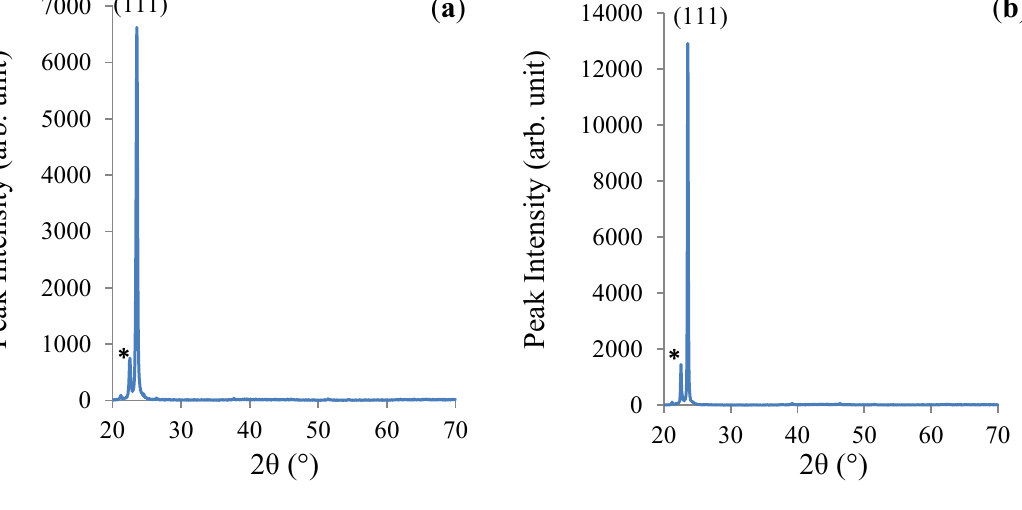
Figure 4. XRD patterns of glass/FTO/CdS/CdTe structure for ( a ) as-deposited CdTe and ( b ) heat treated CdTe (~380 °C for 20 min) with CdCl intensity of the (111) peak and decrease in full width at half maximum (FWHM) indicating the re-crystallisation after heat treatment with CdCl